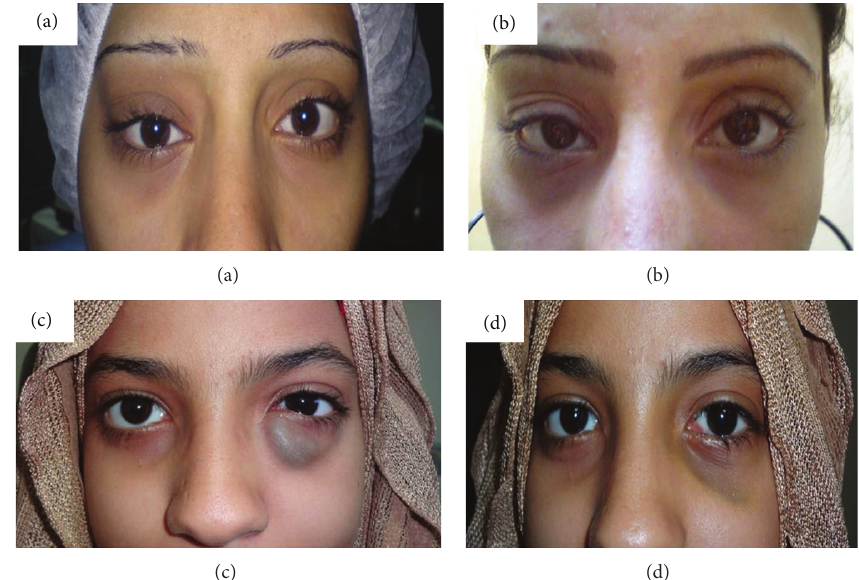
Figure 3: (a) Rt lid fullness, globe displacement, and proptosis in a 22-year-old female. (b) Postoperative improvement of the proptosis with residual globe displacement. (c) Lt recurrent swelling of the lower lid in a 17-year-old female. (d) Postoperative Lt enophthalmos and exaggerated tear trough detected one month after